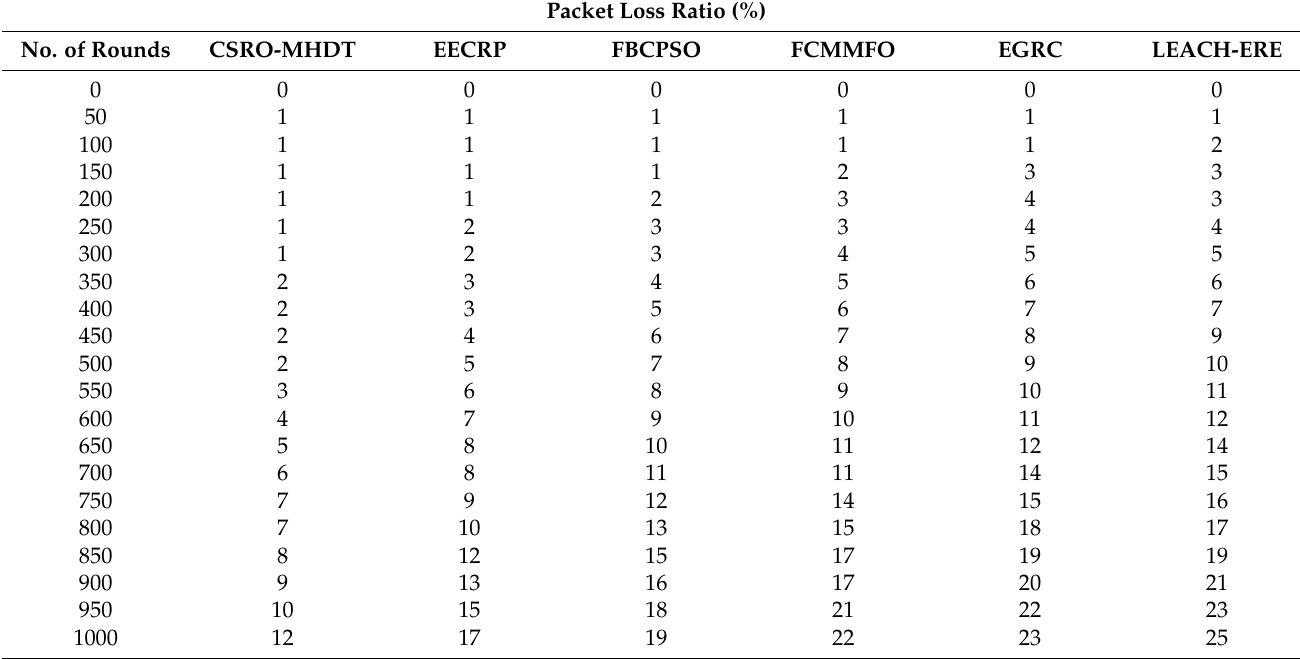
Table 5. PLR analysis of the CSRO-MHDT technique in comparison with existing approaches. Packet Loss Ratio (%)